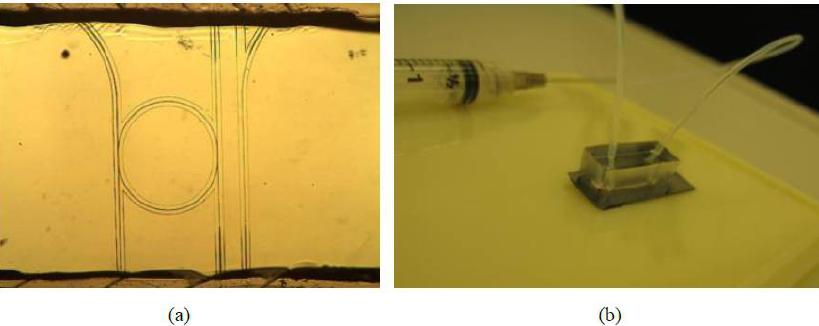
Figure 27. ( a ) The fluidic channel aligned with the ring resonator on the chip and ( b ) a biosensor assembled with fluidic channel and connected to a syringe.